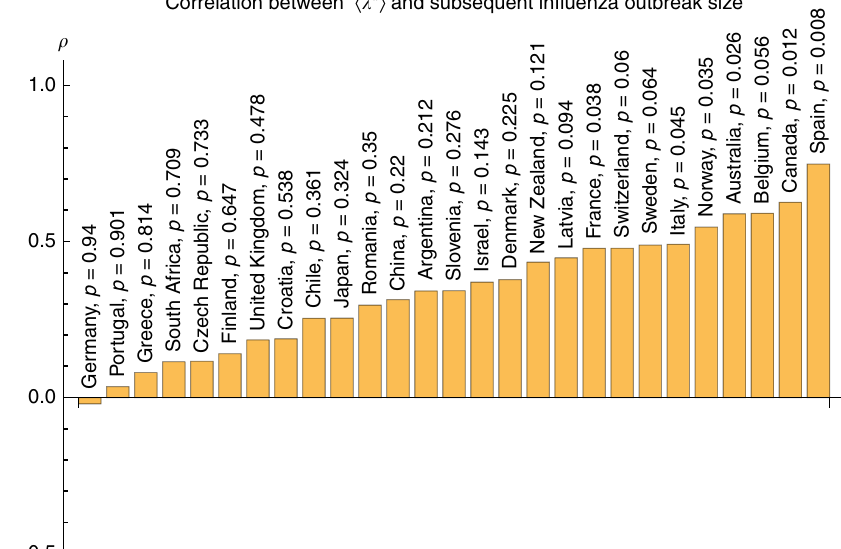
Fig. 4 Demonstration of the method for global in fl uenza. Shows the correlations between the eigenvalues 〈 λ * 〉 and the subsequent in fl uenza outbreak magnitudes in the 27 different countries having less than 80% missing values during the assessment period. Details in the Methods (Supplementary Figs. 5 – 31 for each